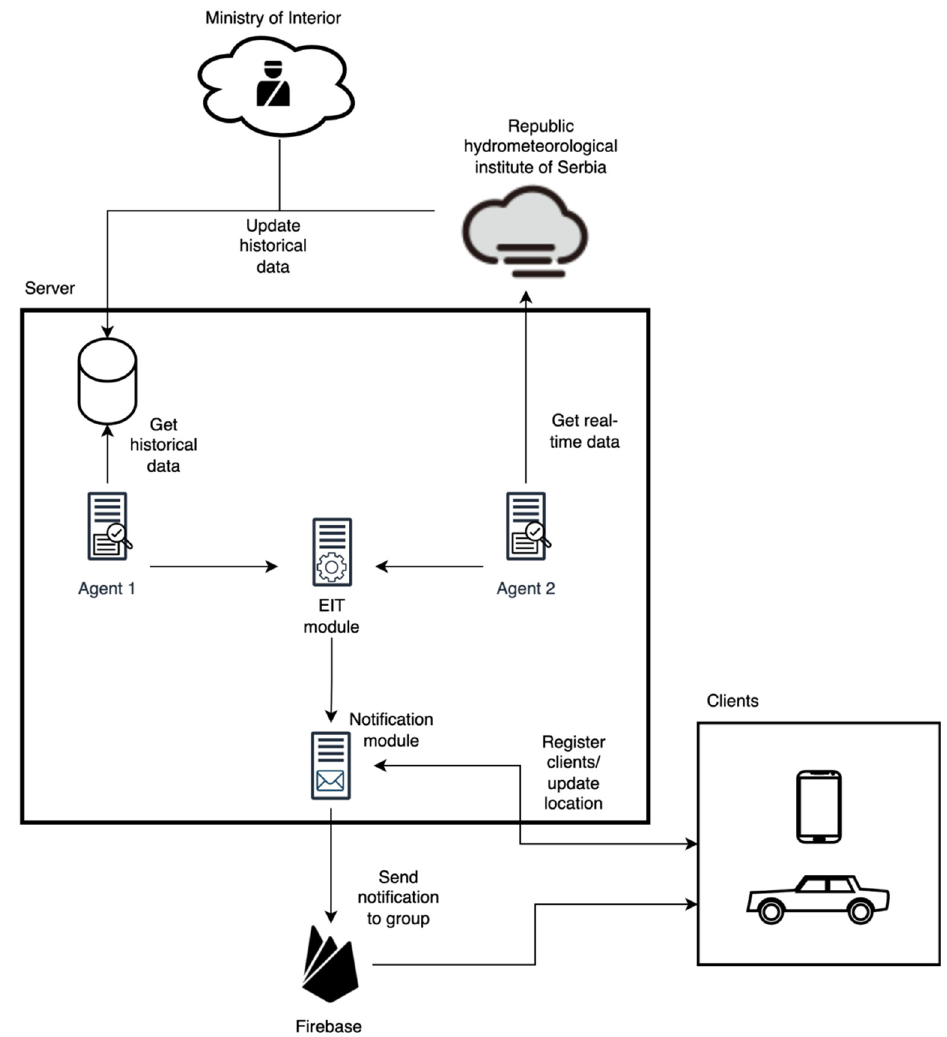
Figure 4. EIT two-agent system implementation—generating a warning of the possibility of traffic accidents.